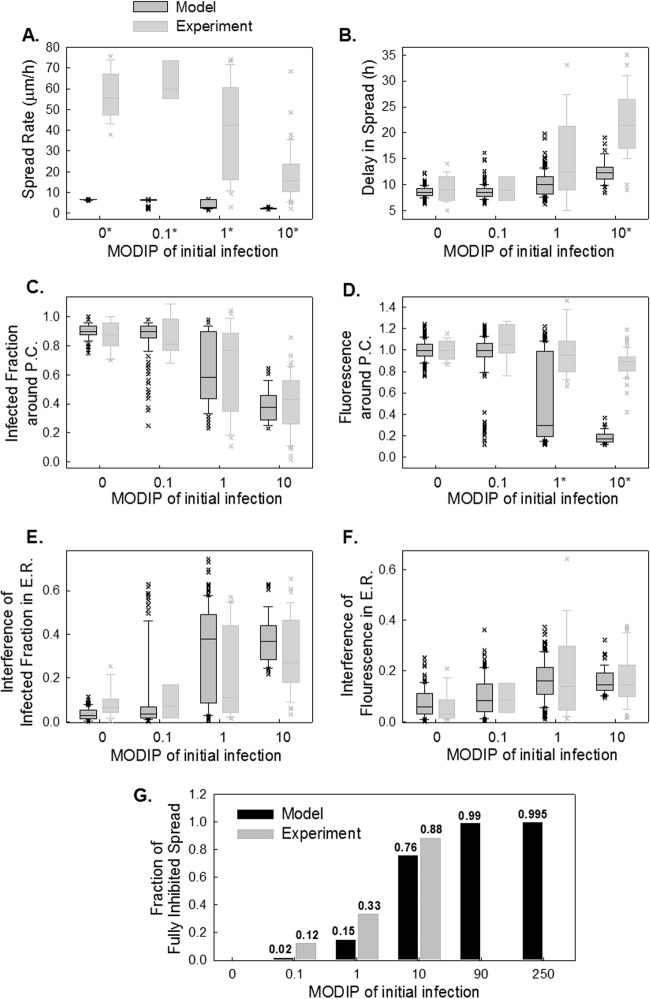
Simulated spread features obtained using optimum parameter set 2. (A to F) Spread rate (A), delay in spread (B), infected fraction (C), relative fluorescence around the plaque center (D), interference in the infected fraction (E), and interference in relative fluorescence in early rounds of spread (E.R.) (F) at each MODIP (abscissa) are simulated with a model parameter set optimized to capture spatial patterns (kad = 0.5; D = 0.025 μm2/s; tsup = 1.5 h; kc = 0.1). Modeled distributions are shown in dark gray box plots along with the measured distributions (light gray box plots). A star next to a MODIP label indicates a significant difference (P < 0.01) between the measured and modeled distributions of the associated feature. (G) The fraction of fully inhibited spread observed in experiments (gray bars) is compared with that estimated by the model (black bars) under tested (MODIP, 0 to 10) and untested (MODIP, 90 or 250) MODIP conditions.